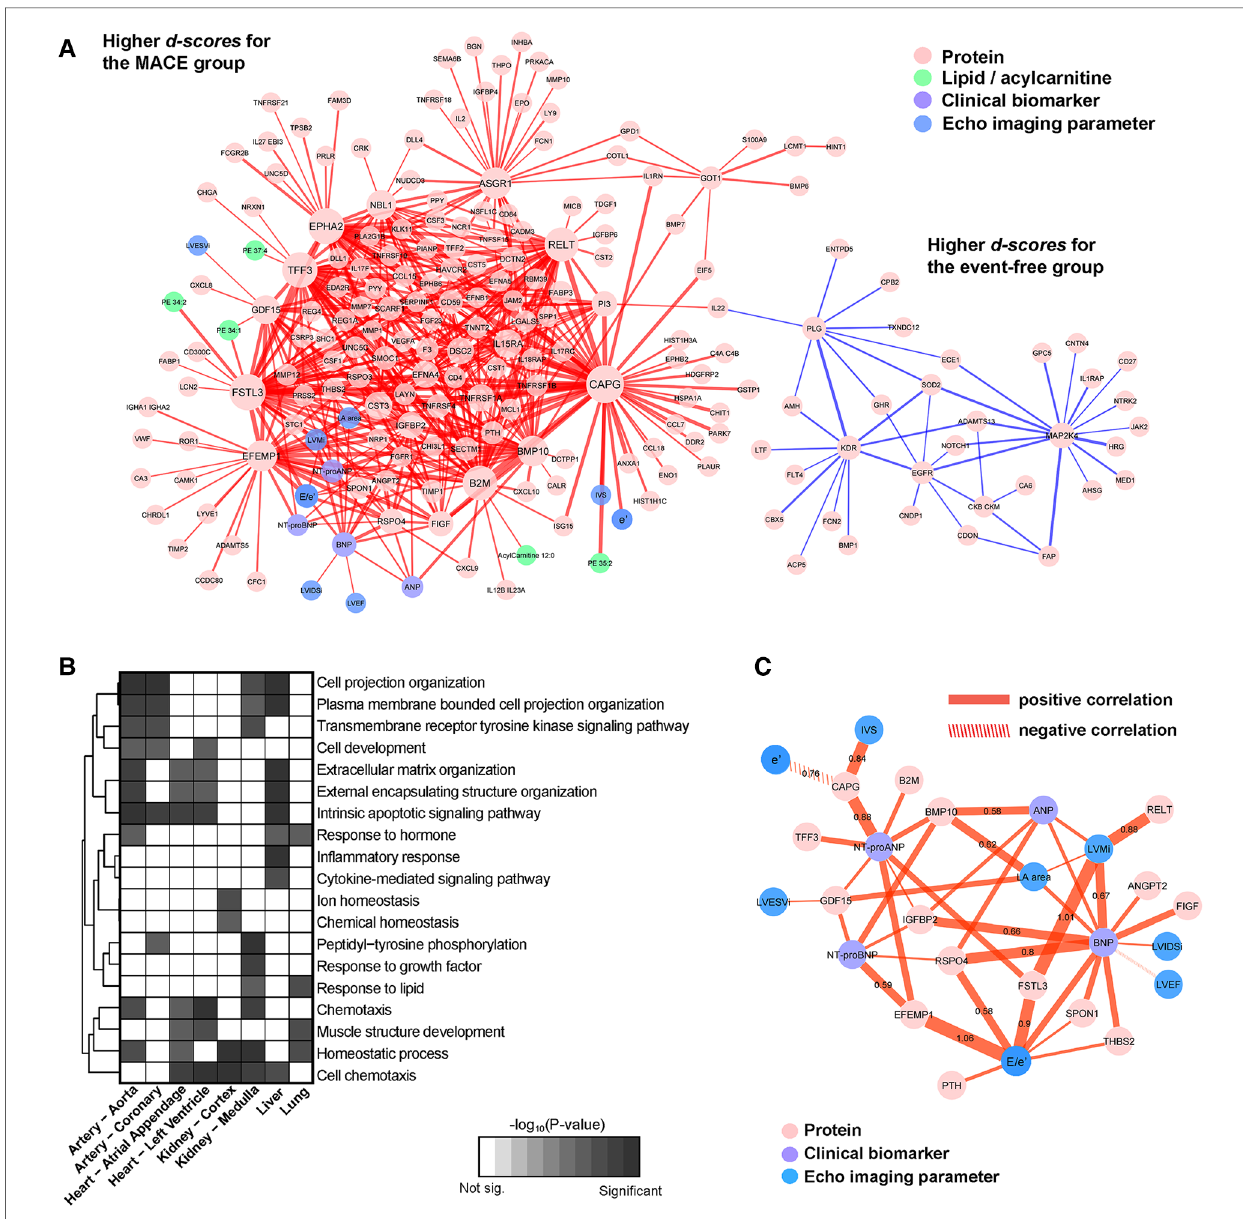
FIGURE 3 Subnetwork signature of MACE. ( A ) Network visualization with plasma proteins, lipids and acylcarnitines, echocardiographic imaging variables, and clinical biomarkers in different colors. Edges were colored according to the signs of the d-scores computed by iOmicsPASS+and the thickness re fl ects the magnitude of the scores representing the discriminatory power. ( B ) Enrichment of biological functions in the constituent nodes in panel ( A ), accounting for tissue-speci fi c expression of genes at the mRNA level (median-normalized TPM>5 in each tissue). ( C ) Visualization of the subset of the network signature illustrating the plasma proteins connected to echocardiographic imaging variables and clinical